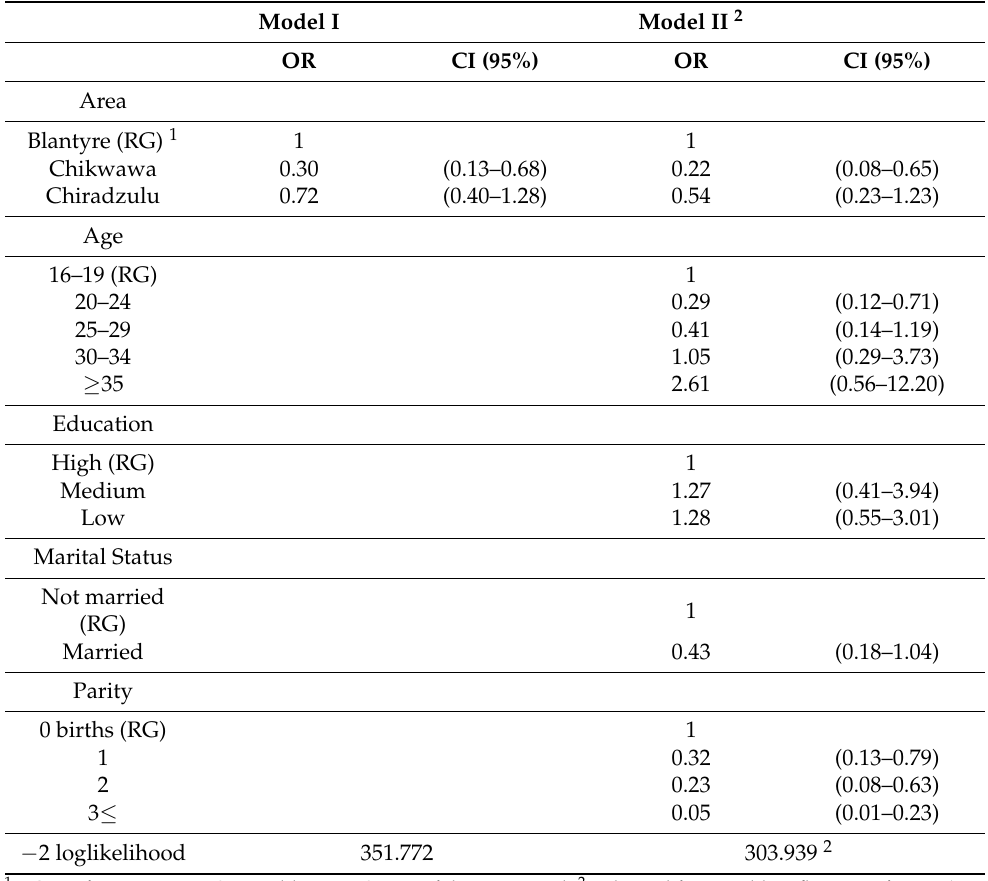
Table 4. Logistic regression analyses for the unmet need of family planning in three hospitals in southern